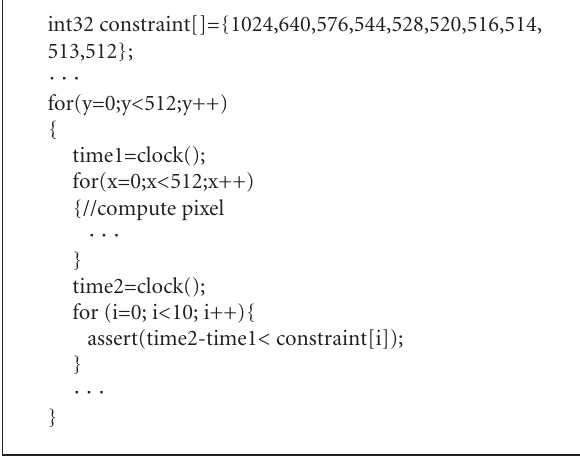
Algorithm 3: Adding timing assertions in a loop to backprojec-